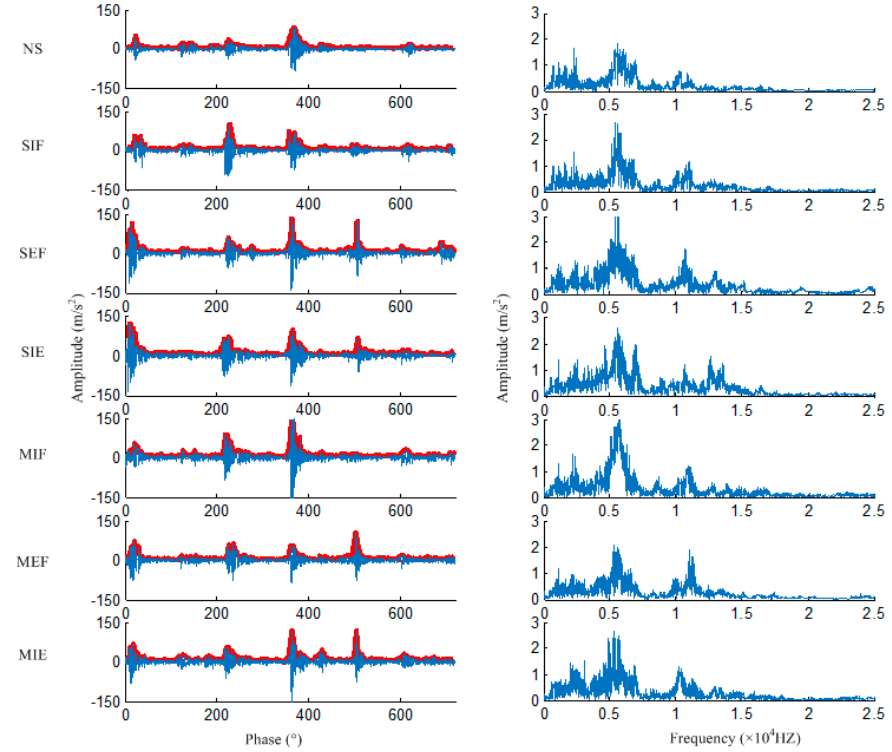
Figure 7. Angular domain, frequency domain signals, and the envelope.